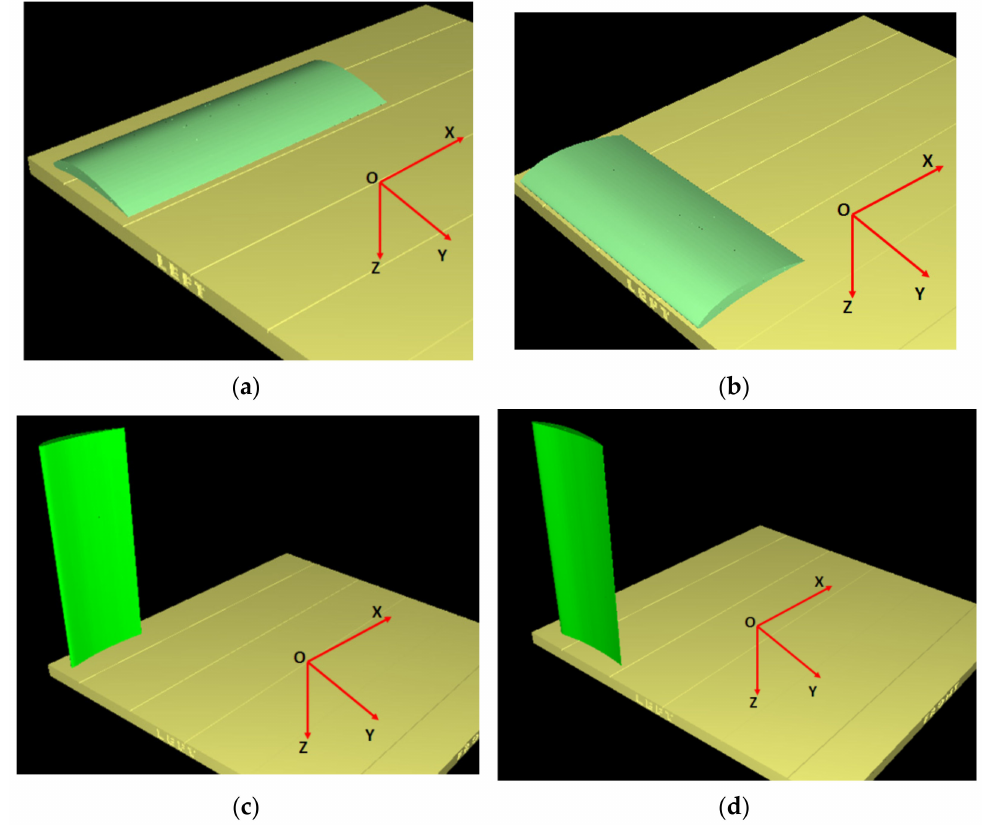
Figure 6. Simulations of the L-SW model in different orientation: ( a ) XY glossy; ( b ) YX matte; ( c ) ZX matte; ( d ) ZY